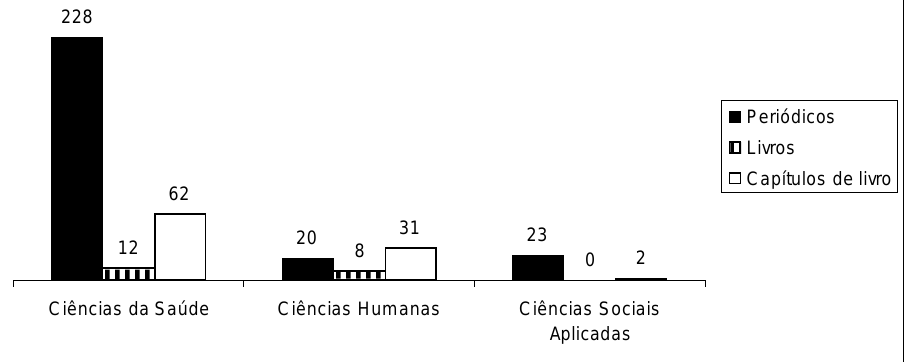
Figura 8. Distribuição da produção científica total dos grupos de pesquisa, no triênio 2006, 2007 e 2008, por área de conhecimento.